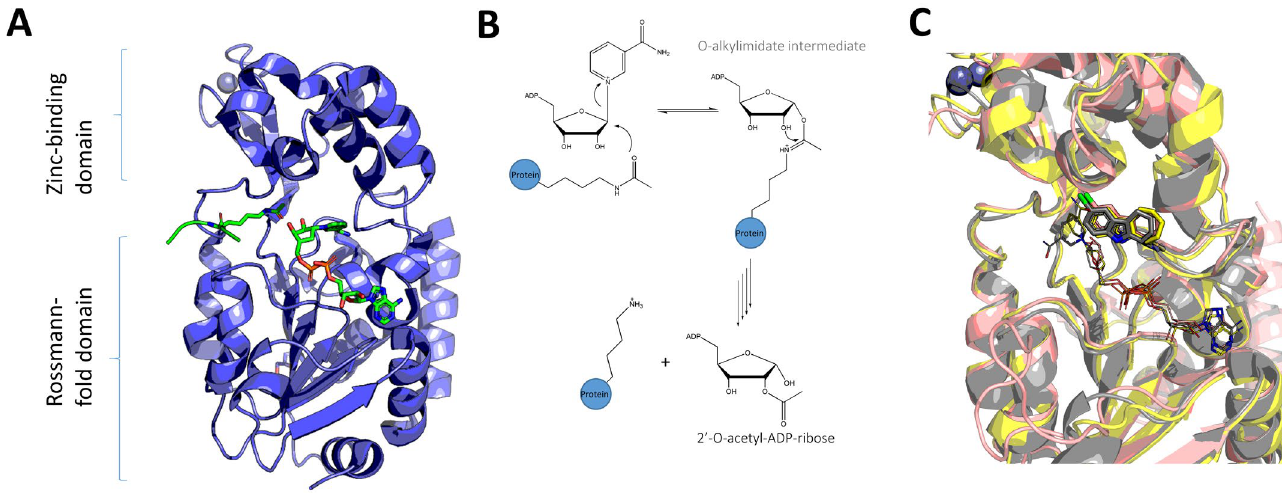
Figure 1. Summary of the sirtuin structures and catalytic mechanism. ( A ) Two domains of sirtuins exemplified on the structure of SIRT3 (PDB ID: 4FVT). NAD + and substrate are presented in green sticks; ( B ) overview of the mechanism of sirtuin-mediated deacetylation; ( C ) problem of achieving sirtuin inhibitor selectivity exemplified through aligned structures of SIRT1 (yellow) (PDB ID: 4I5I), SIRT2 (pink) (PDB ID: 5D7P), and SIRT3 (gray) (PDB ID: 4BV3) (some parts omitted for clarity). Structurally related inhibitors (gray, pink, or yellow sticks) share the same binding mode across all isoforms. NAD + and ADP–ribose are presented in gray, pink, or yellow lines.